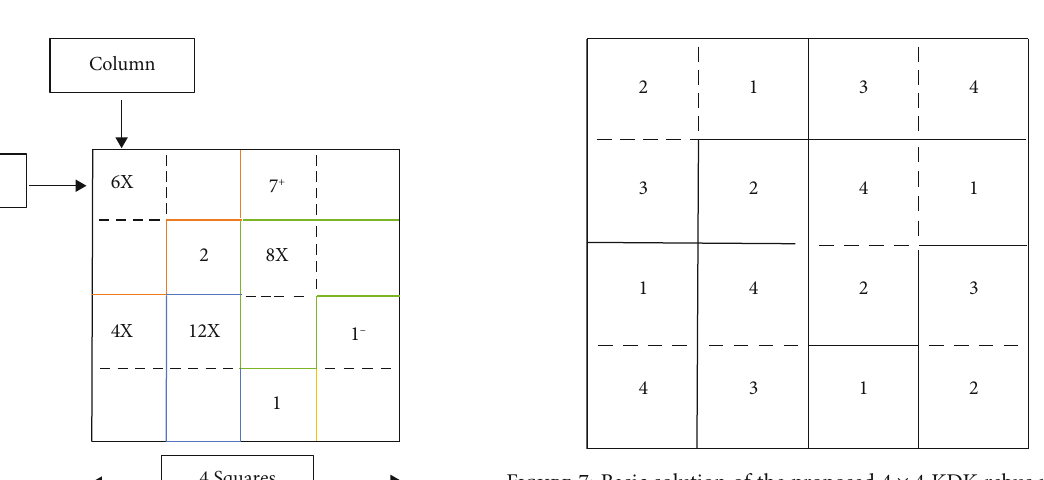
Figure 5: Output characteristics of PV module operating in normal and partial shading conditions: (a) I - V characteristics and (b) P-V